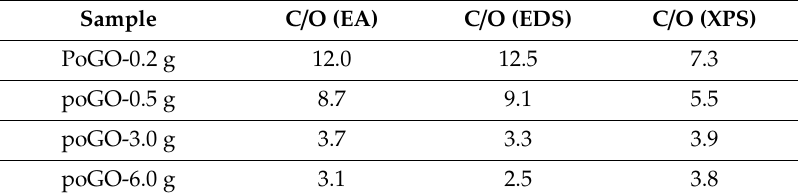
Table 1. Calculated C / O ratios of the partially-oxidized graphite oxides (poGOs). Measurements were obtained by EA, EDS, and XPS. Expected relative uncertainty is less than 1% for all analytic techniques. Sample C / O